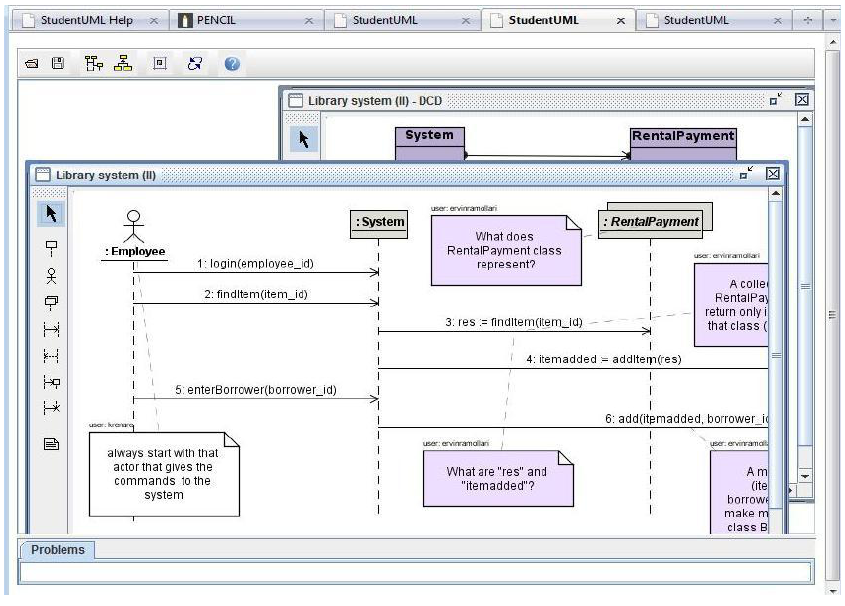
Figure 5. Screenshot of the StudentUML Web application as part of the learning